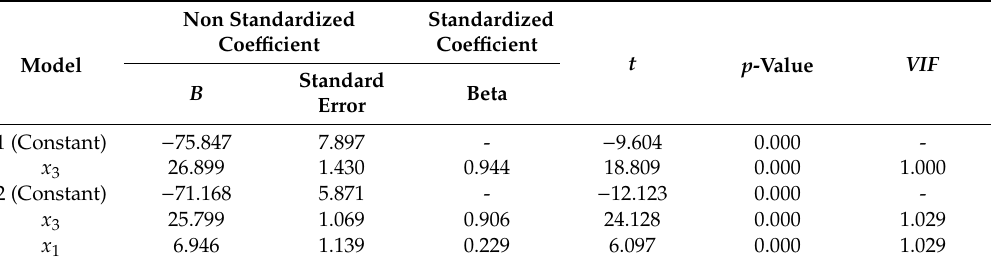
Table 5. Regression coe ffi cient based on the stepwise